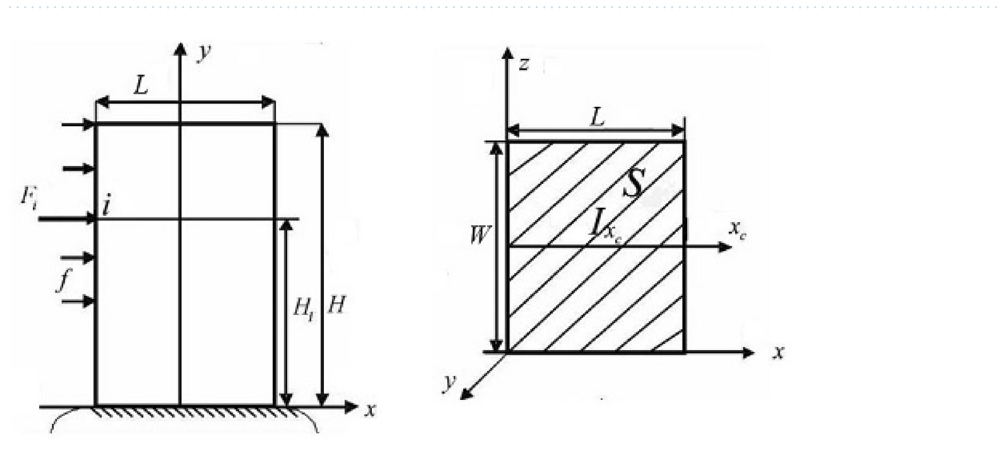
Figure 3. Spline teeth deformation types and characteristics.